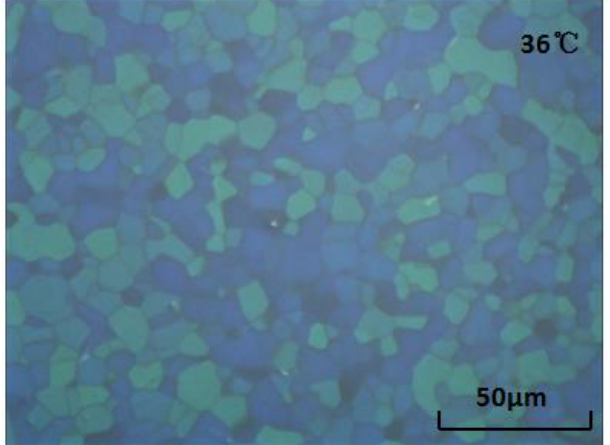
Figure 4. The typical blue phase